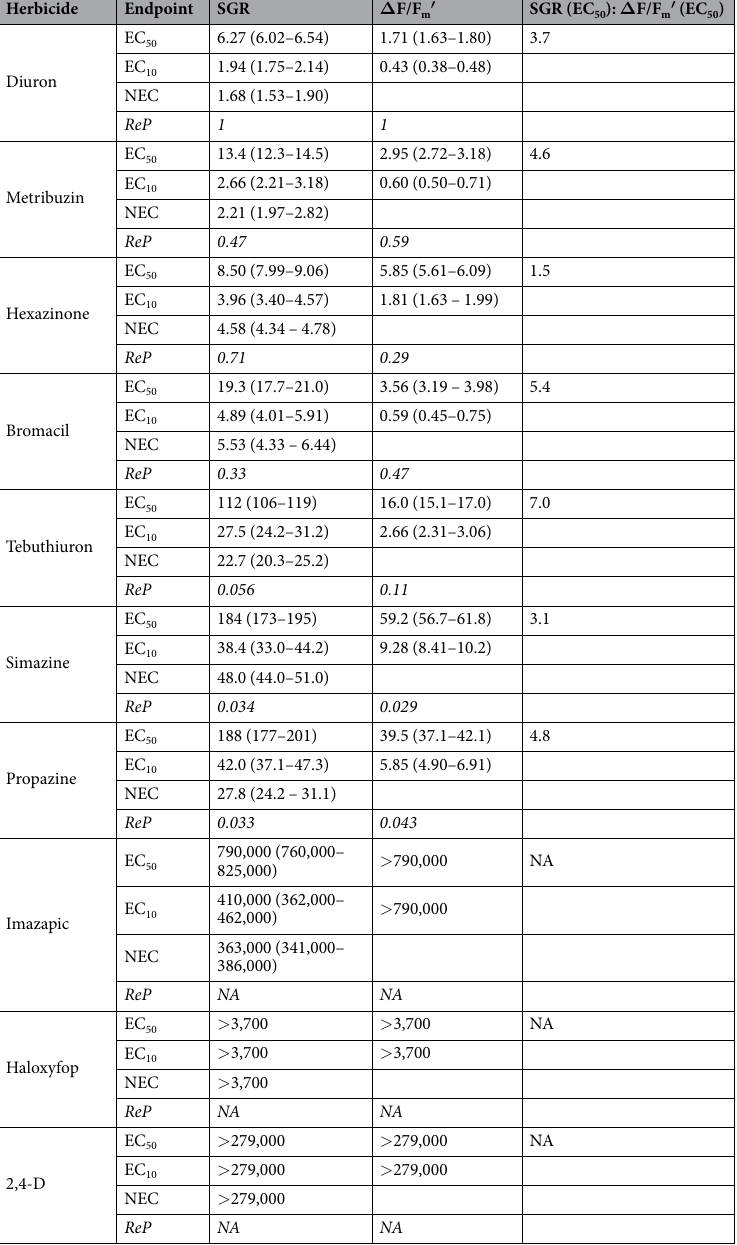
Table 3. Toxicity threshold summary. Derived effect concentrations (EC 10 and EC 50 from Fig. 1) and no effect concentrations (NECs from Fig. 2) with 95% confidence intervals for each herbicide, and relative equivalent potencies (ReP). NA indicates values could not be calculated. Concentrations are reported in µ g L − 1